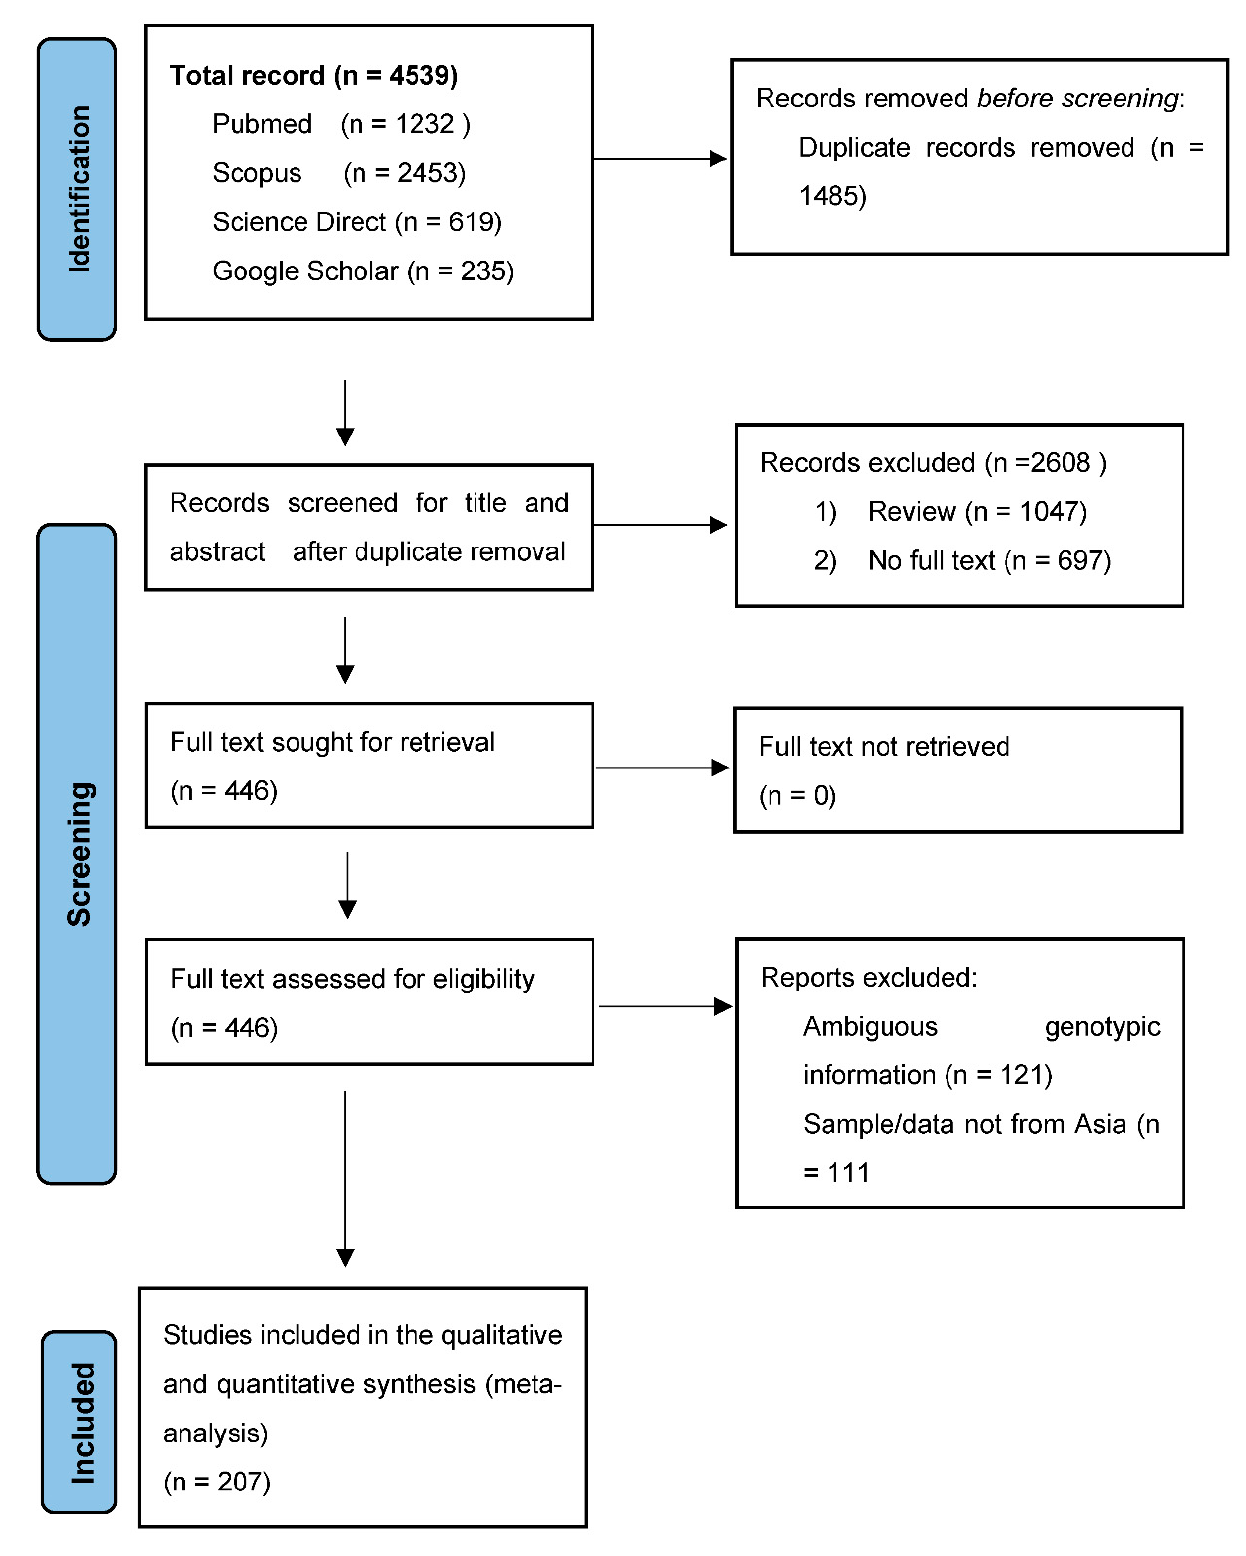
Figure 1. Summary of the article selection process.